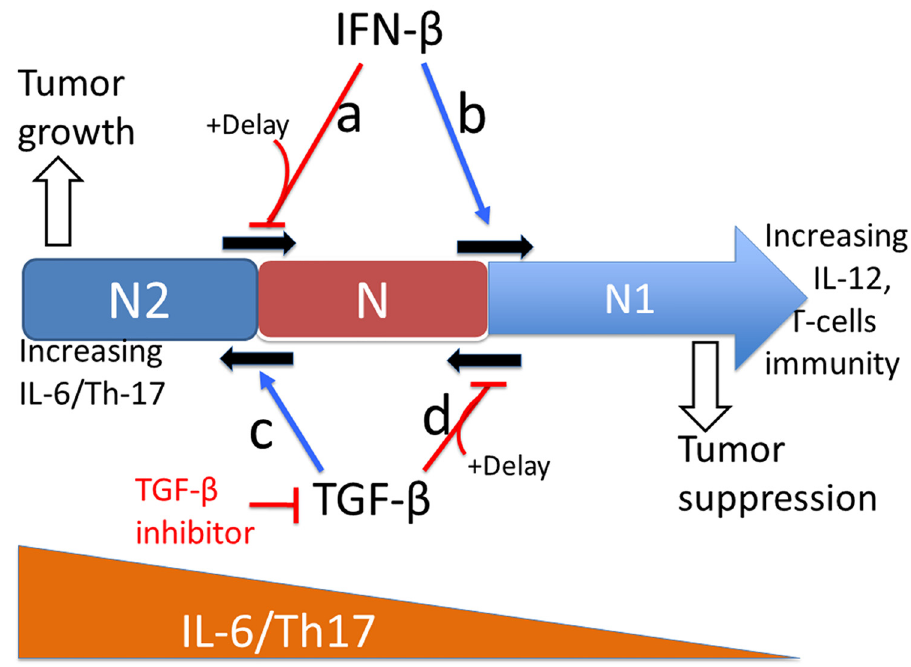
Fig 3. Tumor suppressive and tumor promoting roles of TGF- β and IFN- β respectively in the tumor microenvironment. As the CD8+ cytokines (IL-12) increase, differentiation of N cells transits to the N1 phenotype. There are three ways that IFN- β , TGF- β inhibitor, and delayed apoptotic pathways can keep the system in the safe- guard immune N1 zone. (Cases a, b) Increasing IFN- β levels induces the transition from N2 to N1-zone (case b) [22– 25, 35–37]. The delayed apoptotic cell death of N2 TANs suppresses entry into the transition phase (case a). (Cases c, d) As the IL-6 level is increased (to the left), the tumor-promoting phenotype, N2, becomes dominant and TGF- β promotes the exit from the transition zone to enter the N2-zone (case c) [35]. The TGF- β inhibitor can reverse the phenotype back to the N1 microenvironment [38]. The delayed apoptotic cell death of N1 TANs suppresses entry into the transition phase (case